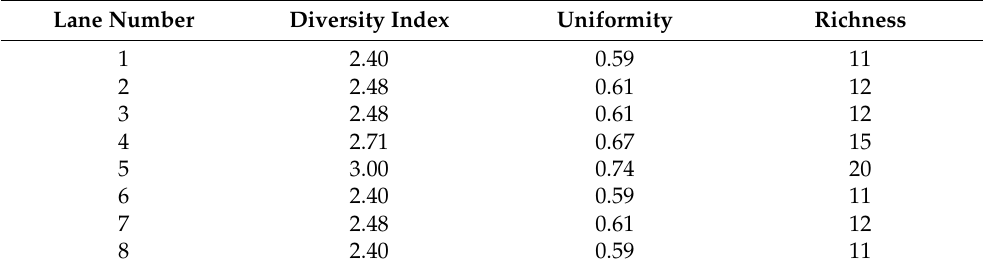
Table 8. Effects of inoculants on the Shannon diversity index of DGGE profiles of different moisture Lolium multiflorum Lam. silage after aerobic exposure for 3